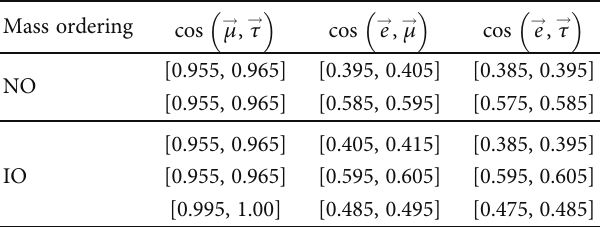
Figure 5: The number of scattered points corresponding to a series of small intervals of cos ð e ! , μ ! Þ and cos ð e ! , τ ! Þ in the IO case of Figure 2, ! Þ ! with the constraint of 0 : 995 < cos ð μ , τ < 1 : 00 . Table 2: The intervals of the angles between the row vectors with the largest number of scattered points stem from every dense regions of Figure